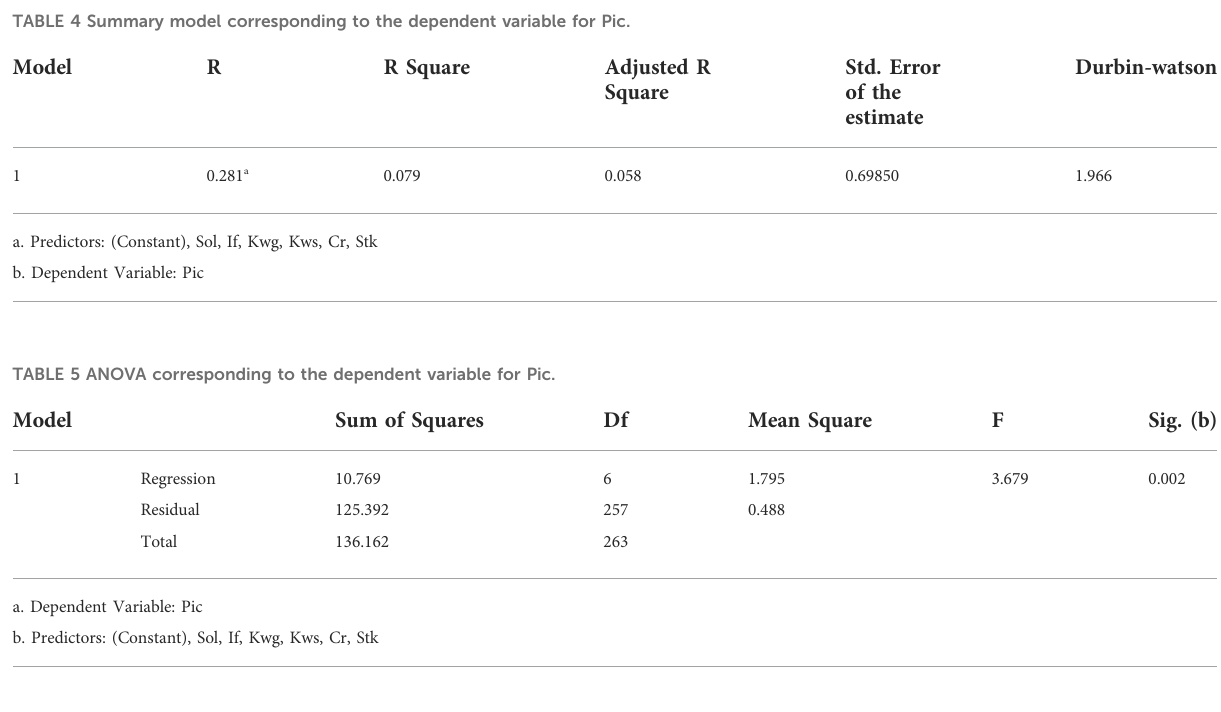
TABLE 6 The coef fi cient of the independent variables for the Pic